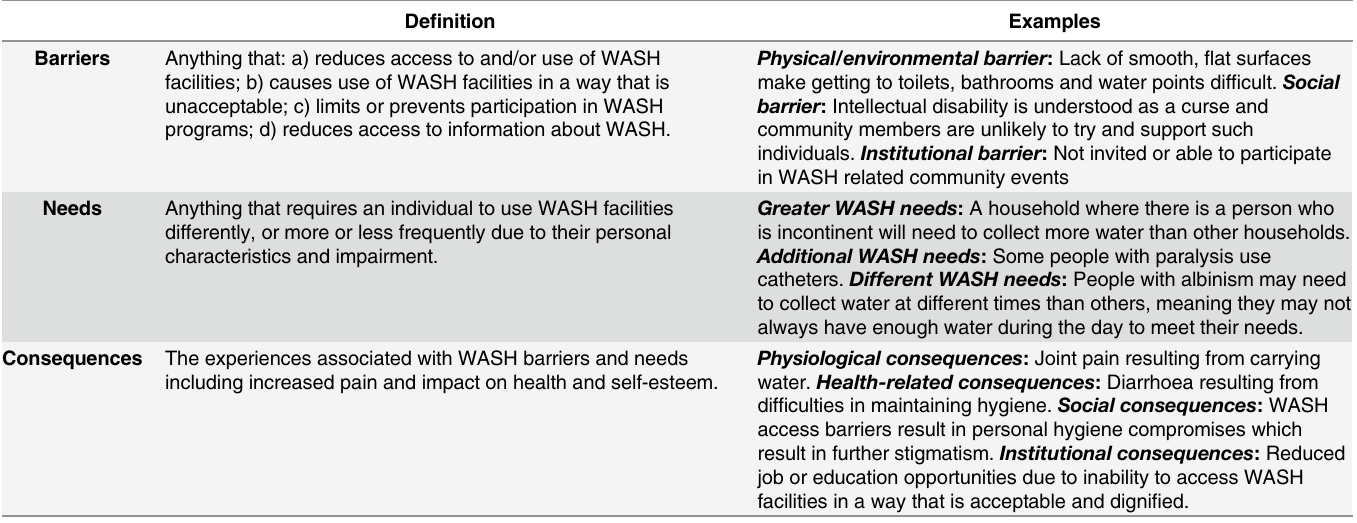
Table 7. Definitions of WASH barriers, Needs and